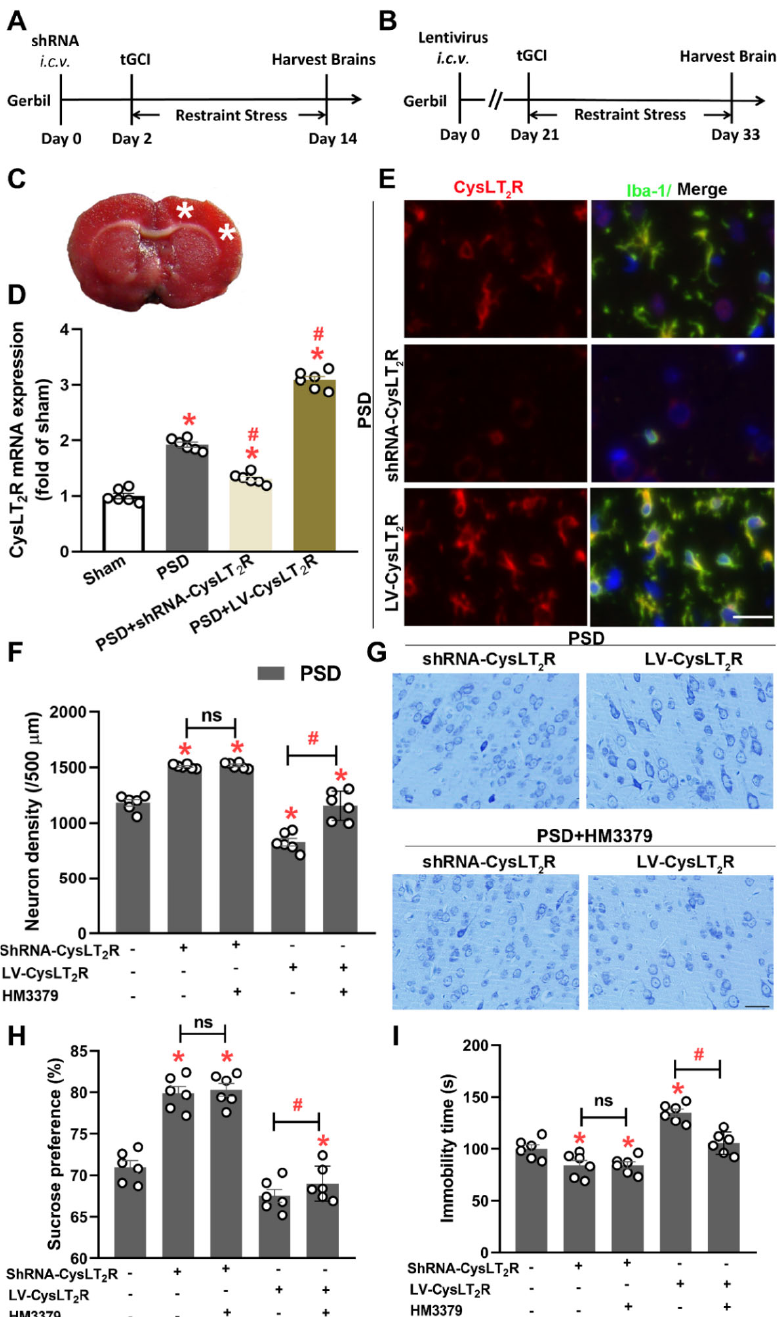
Figure 6. HM3379 protected against PSD-induced depression-like behaviors through CysLT 2 R in gerbils. ( A , B ) Schematic diagram of injected shRNA-CysLT 2 R and LV-CysLT 2 R by i.c.v . ( C ) The white asterisk on the photograph of TTC-stained coronal slices showed the injection site. ( D ) Quantitative analysis of CysLT 2 R mRNA expression in sham, PSD, PSD + shRNA-CysLT 2 R, and PSD + LV- CysLT 2 R groups. ( E ) Immunofluorescence staining of Iba-1 (green) and CysLT 2 R (red) revealed CysLT 2 R expression in microglia after injection of shRNA-CysLT 2 R and LV-CysLT 2 R. ( F ) Neuronal density in the cortex regions. HM3379 significantly ameliorated neuronal loss in the PSD-induced gerbil model by inhibiting CysLT 2 R. ( G ) Representative photomicrographs of Nissl-stained brain sections. HM3379 depending on CysLT 2 R improved depression-like behavior in sucrose preference test ( H ) and forced swim test ( I ) in PSD gerbils. Data are presented as mean ± SEM. * indicates p < 0.05 vs. sham, # indicates p < 0.05 vs. PSD. N = 6 per group. Scale bars = 50 µ m. ns, no significant difference. PSD, post-stroke depression. tGCI, transient global cerebral